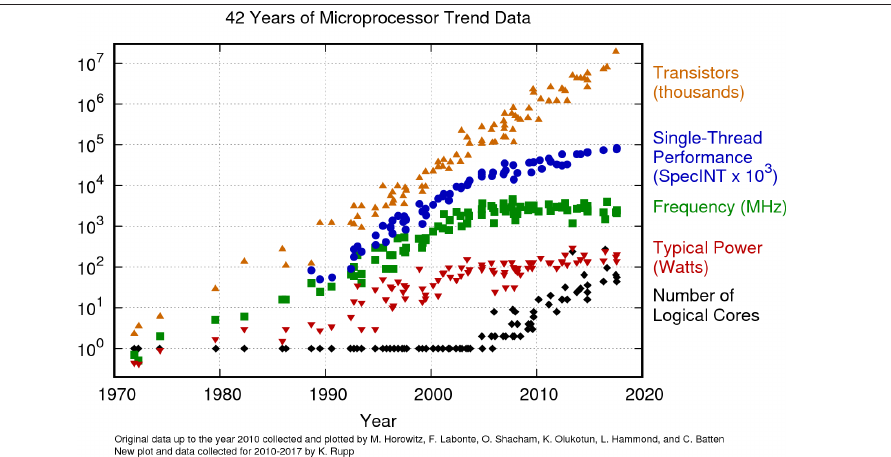
Figure 3: History of Intel chip introductions by clock speed and number of transistors over the past 50 years